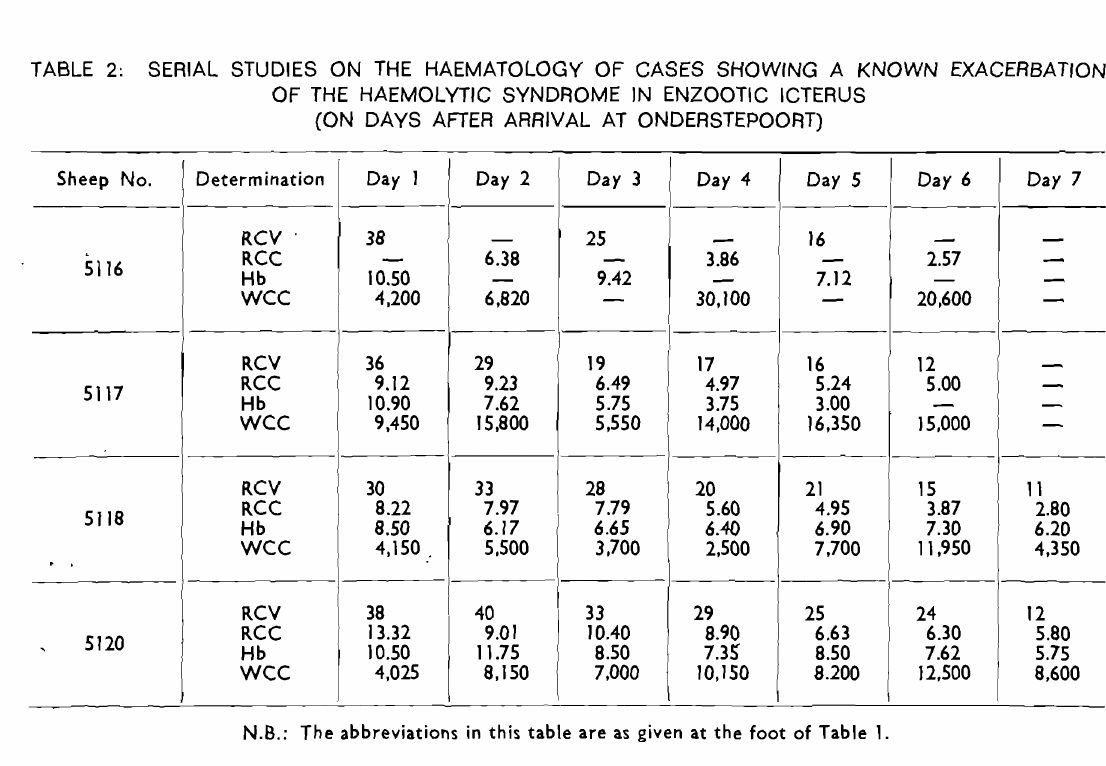
TABLE 2: SERIAL STUDIES ON THE HAEMATOLOGV OF CASES SHOWING A KNOWN EXACERBATION OF THE HAEMOLVT/C SVNDROME IN ENZOOTIC ICTERUS (ON DAVS AFTER ARRIVAL AT ONDERSTEPOORT) Sheep No.